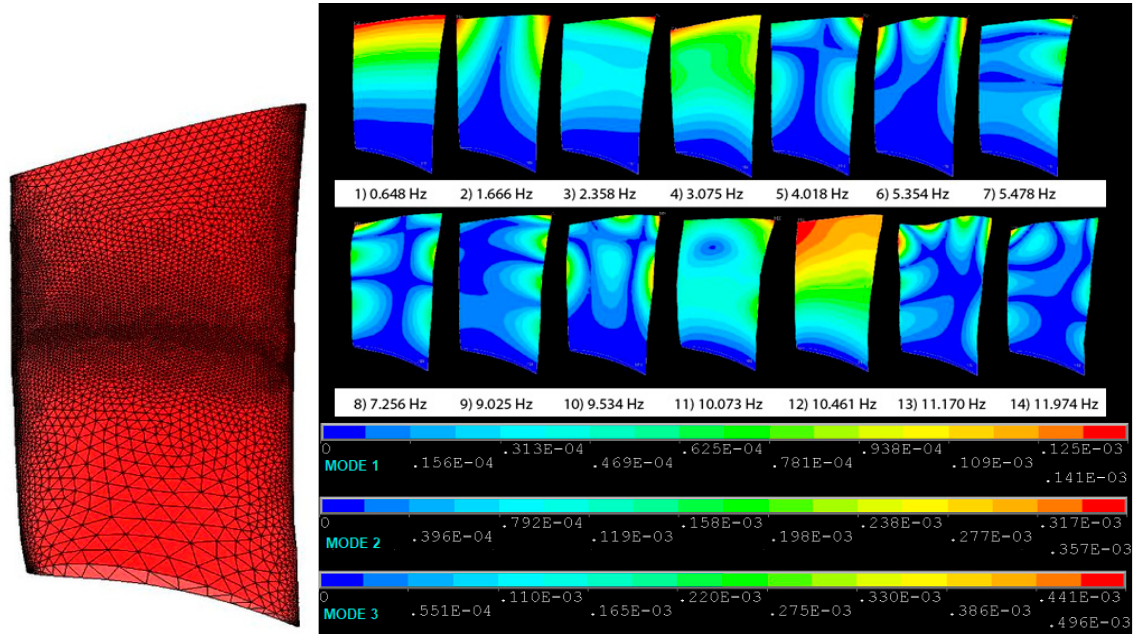
Figure 14. Rotor 3 tetrahedral mesh and 14 modes of the nodal solution.